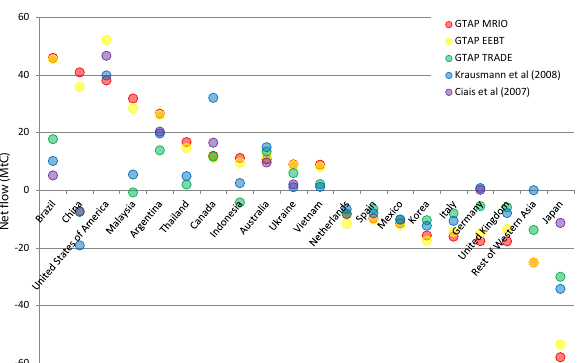
Fig. 12. A comparison of different methods of estimating the carbon trade in crops for the 20 largest net (exports minus imports) flows (see text). The Ciais et al. results are for 1997, Krausmann et al. for 2008, and the MRIO, EEBT, and TRADE results are for